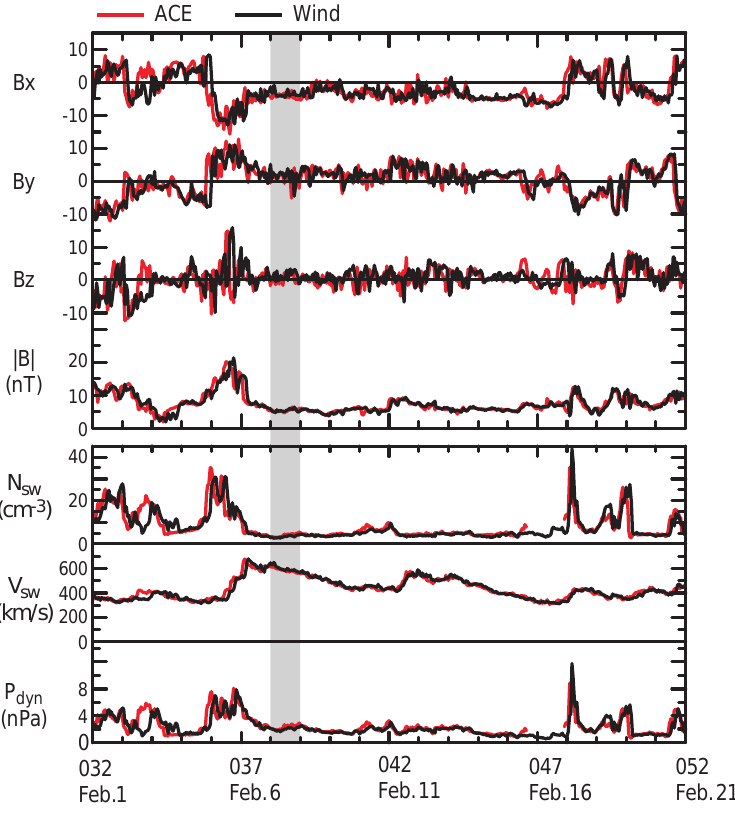
Fig. 1. Twenty days of hourly magnetic field and solar wind plasma data from ACE (red) and Wind (black), with the event day 7 February